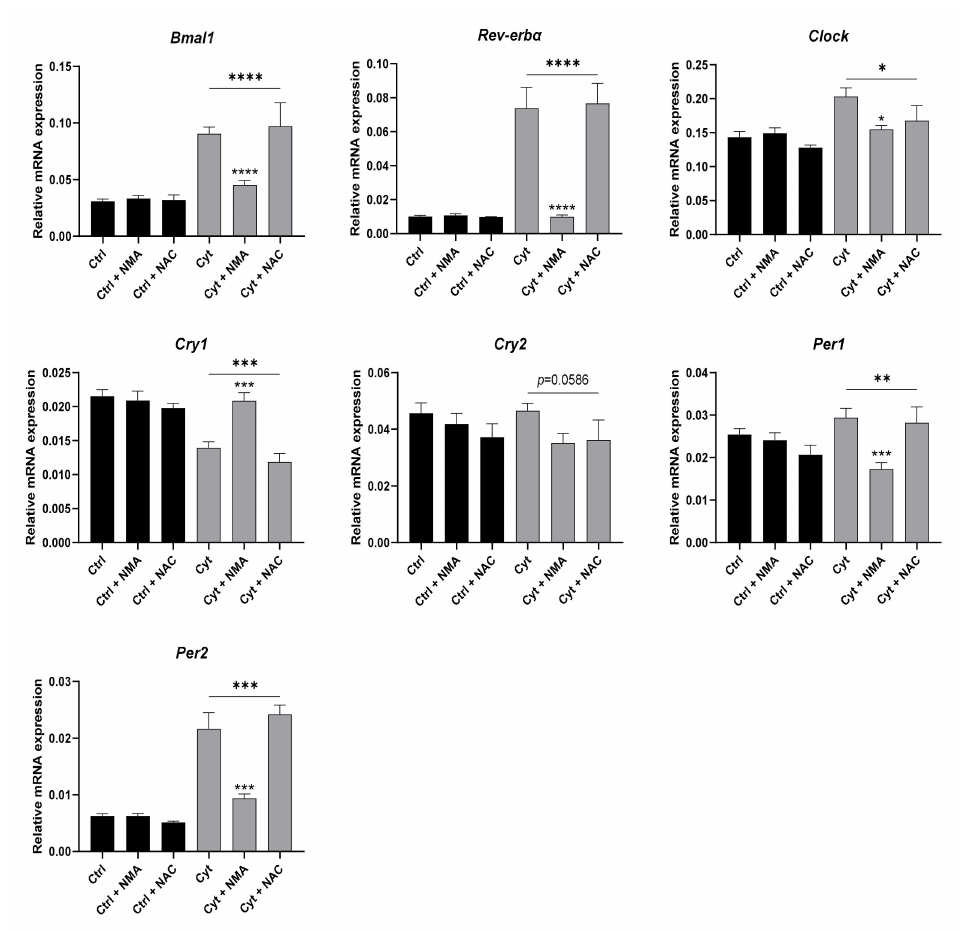
Figure 8. Inhibition of nitroxidative, but not oxidative, stress reverses the cytokine-mediated changes in clock gene expression in non-synchronized INS-1 cells. INS-1 cells were treated with 1 mM NAC or 1 mM NMA for 12 h with or without or without 150 pg/mL mouse IL-1 β + 0.1 ng/mL rat IFN- γ (Cyt). Relative mRNA expression is calculated using Hprt1 and 5S rRNA as reference genes. Values are means ± SEM ( n = 3–9). Statistics are one-way ANOVA with p -values represented by symbols above the line and with Dunnett’s corrected multiple comparisons to Cyt (gray bars). Significance levels were annotated as follows: * = p -value < 0.05, ** = p -value < 0.01, *** = p -value < 0.001, **** = p -value <